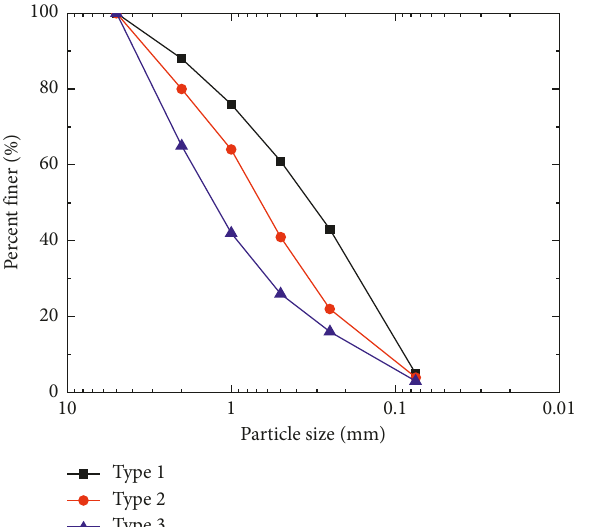
Figure 2: The OD 600 value of the bacteria solution at different pH values.